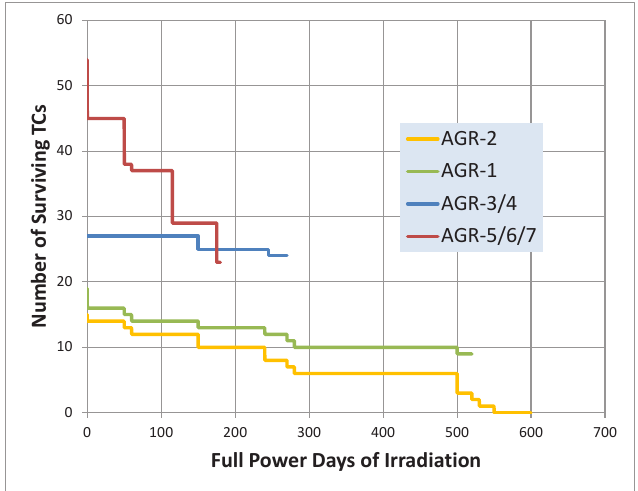
Fig. 4. Thermocouple failure trends for AGR-1, AGR-2, AGR-3/4, and AGR-